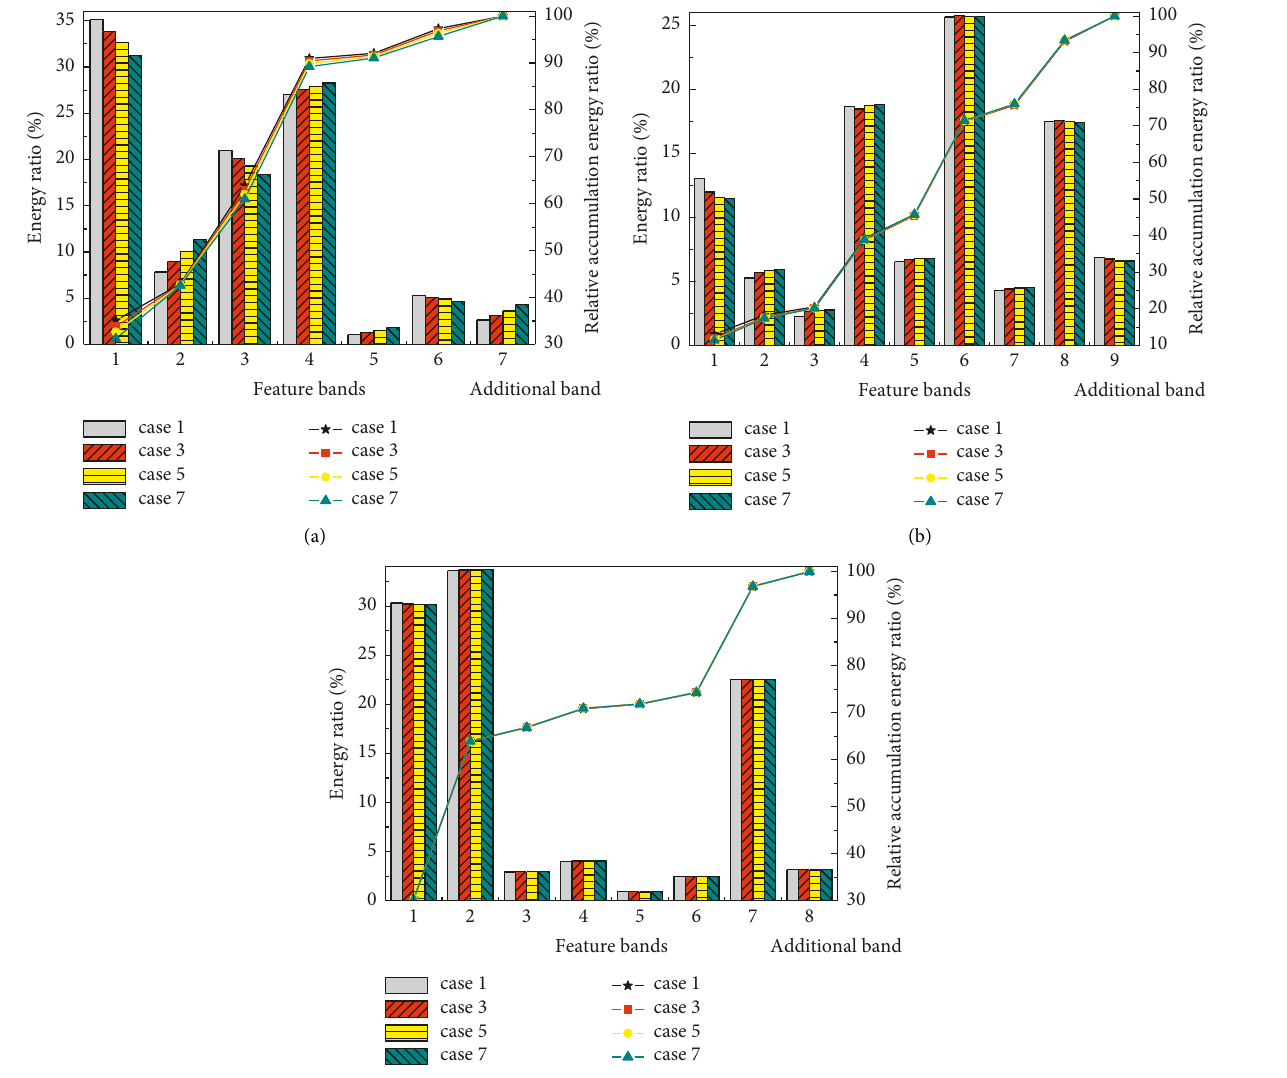
Figure 9: The Wavelet Packet feature vector of different measurement points (the second time test at excitation point II, ε (b) Point 5. (c) Point